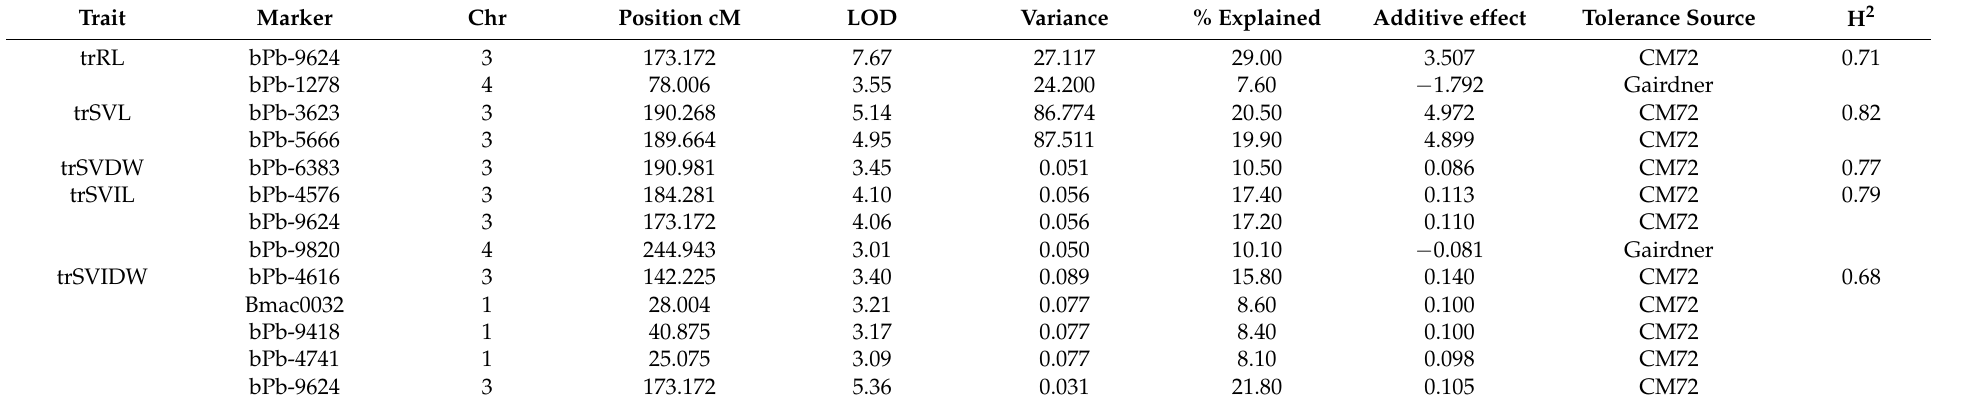
Table 3. Quantitative Traits Loci (QTL) linked with seedling survival traits mapped using CM72/Gairdner DH